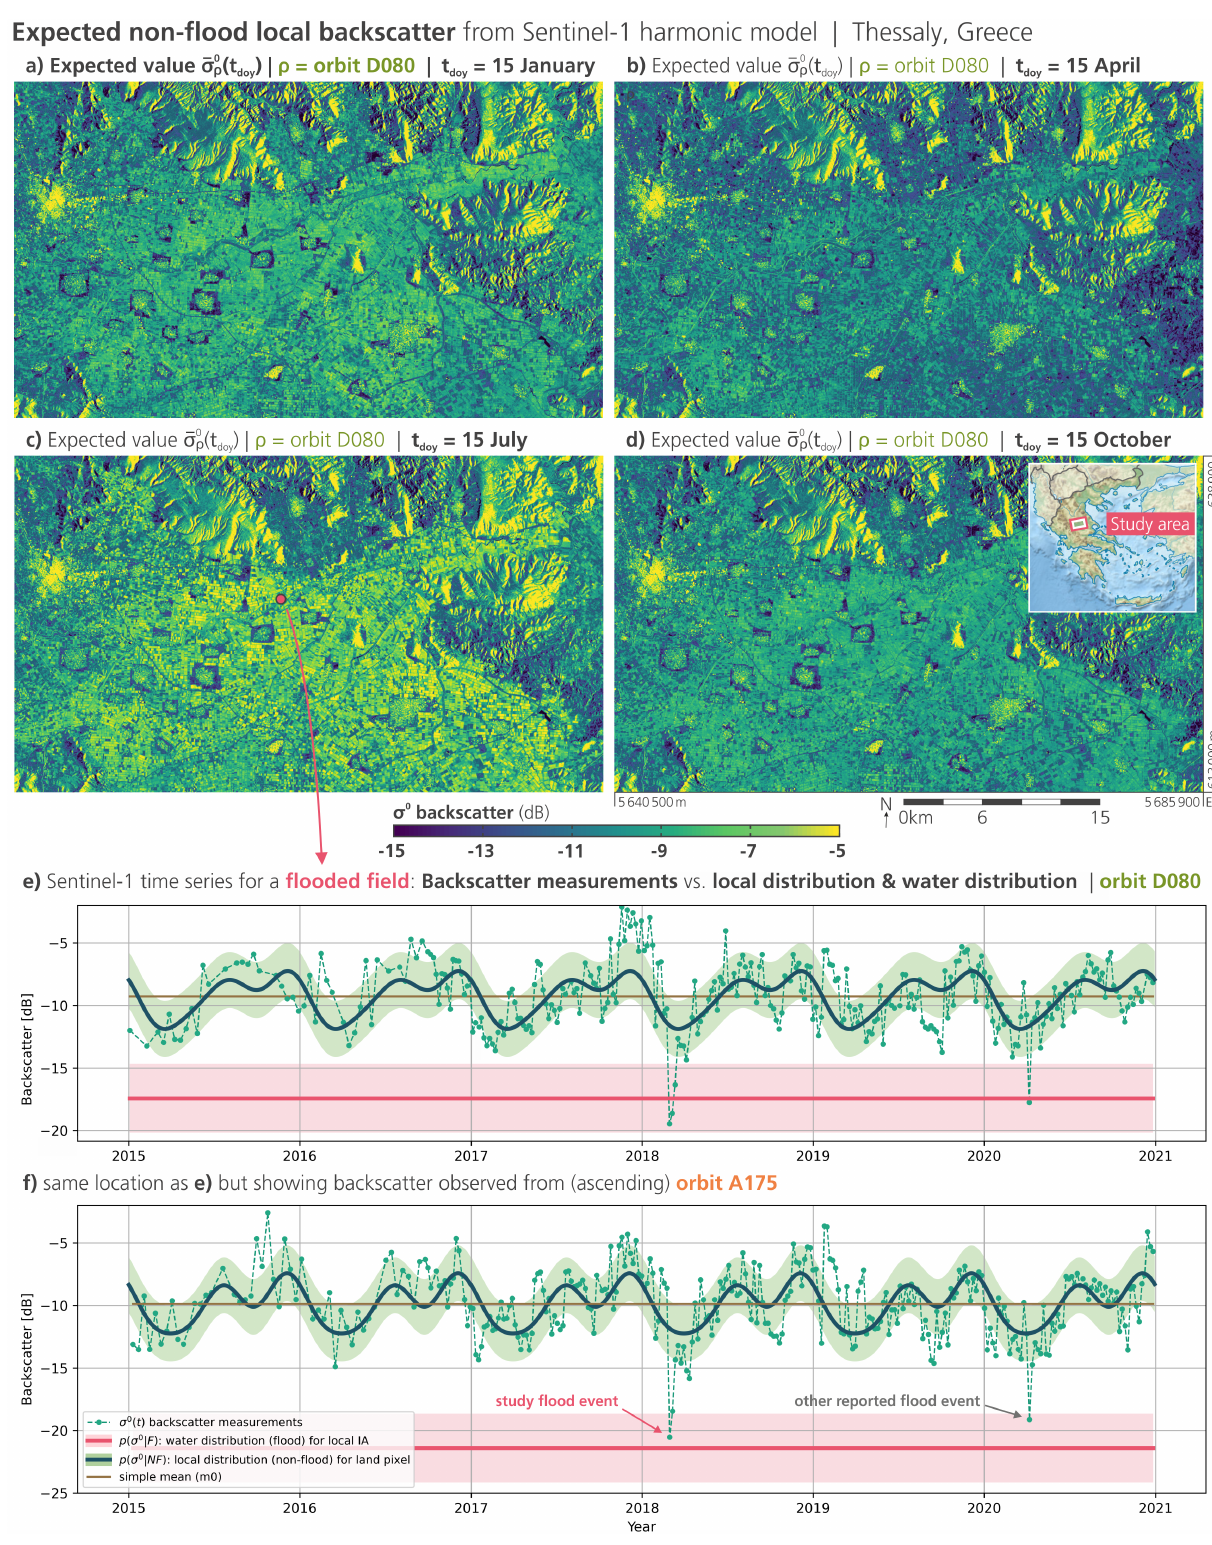
Figure 4. Over Thessaly, Greece, ( a – d ) examples from the local distribution dataset for four selected days of the year ( doy ), i.e., the expected backscatter σ 0 ρ ( t doy ) for relative orbit ρ = D 080 resulting from the harmonic analysis defined by Equation (5). Additionally, ( d ) contains the Equi7Grid- coordinates, and the location of the study site as a minimap. ( e , f ) For two relative orbits, example temporal plots showing (expected) local distribution over observed backscatter and the (locally static) water